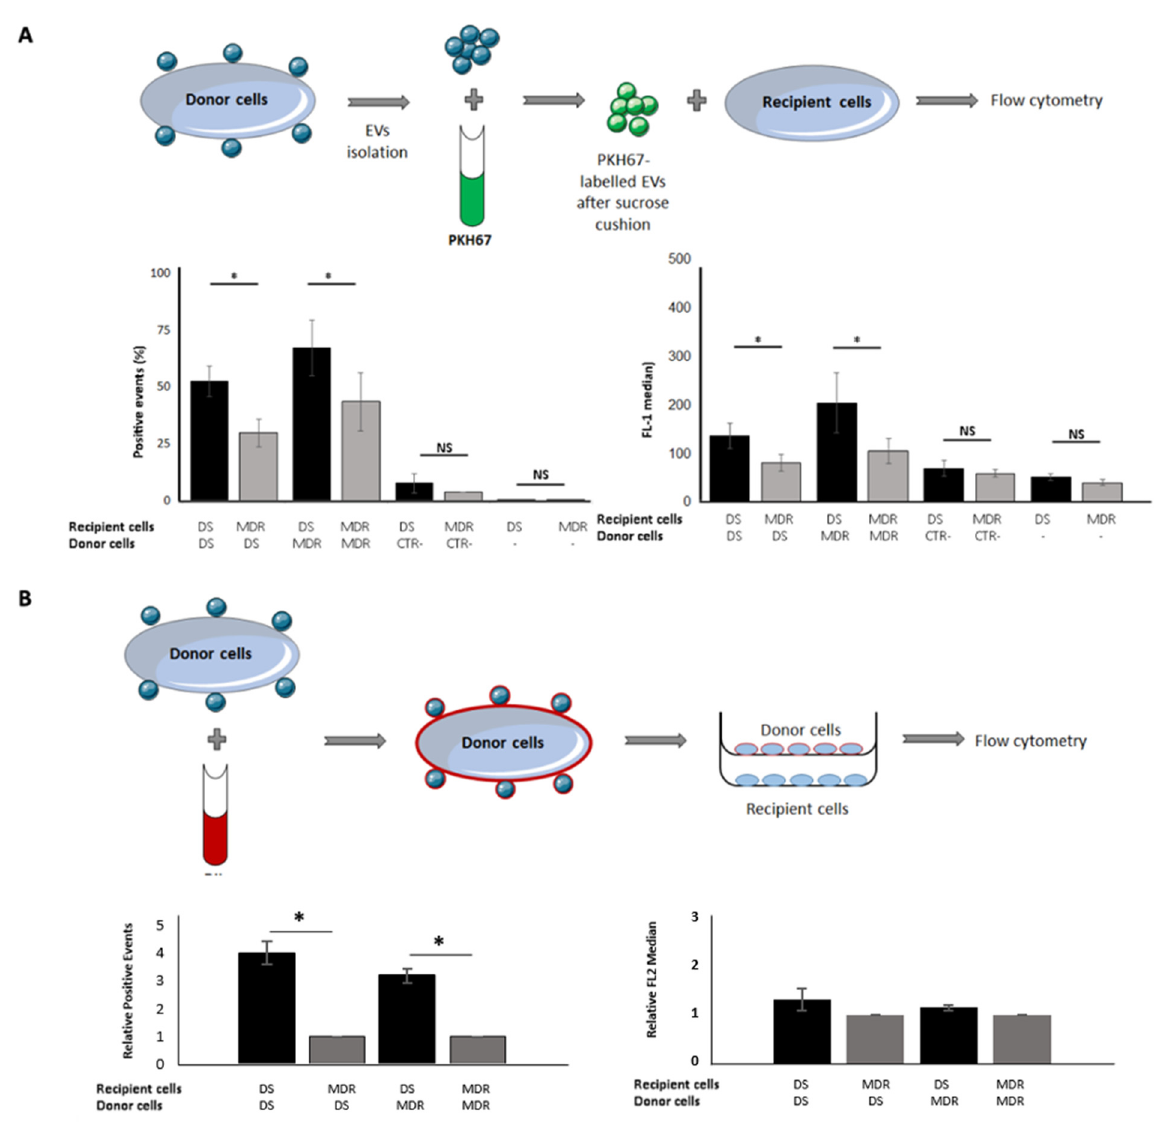
Figure 2. Comparison of EVs capture by drug-sensitive and MDR cells, using two approaches: PKH67 labelling of EVs ( A ) and DiI labelling of donor cells ( B ). ( A ) EVs isolated from K562 and K562Dox cells were labelled with PKH67 and incubated with recipient cells (K562 or K562Dox). Upper panel: experiment layout; lower panel: percentage of positive events and FL-1 median values. Results are presented as mean ± SEM from three independent experiments. ( B ) Donor cells (K562 or K562Dox) were labelled with DiI and incubated with recipient cells (H460 or H460/R) using a trans-well system (0.4 µm). Upper panel: experiment layout; lower panel: percentage of positive events and PE-A median (relative to MDR cells as recipient). Results are presented as mean ± SEM from three independent experiments. * p ≤ 0.05, NS-non-significant.